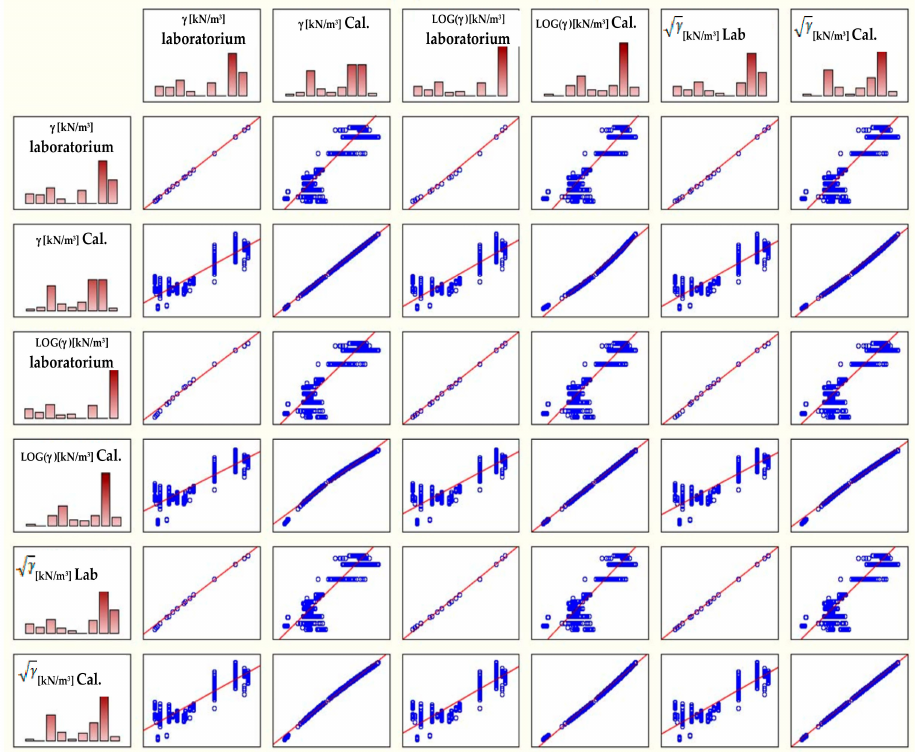
Figure 6. Matrix of extended charts for selected variables (soil unit